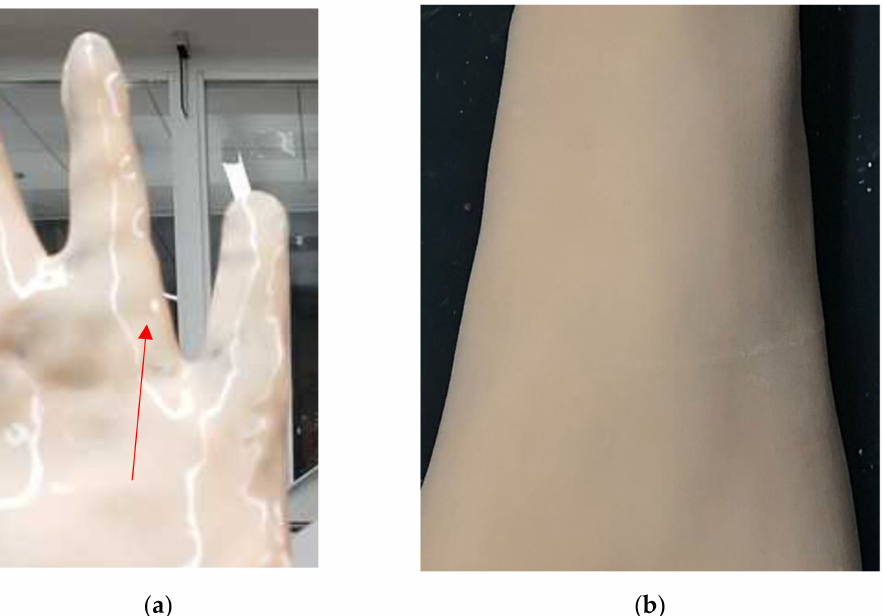
Figure 4. ( a ) DragonSkin surface cured open to the air, arrow points to reflected light indicating a high gloss finish. ( b ) DragonSkin surface cured on FormLabs resin 3D-printed overmold, the matte finish results in a dull but uniform